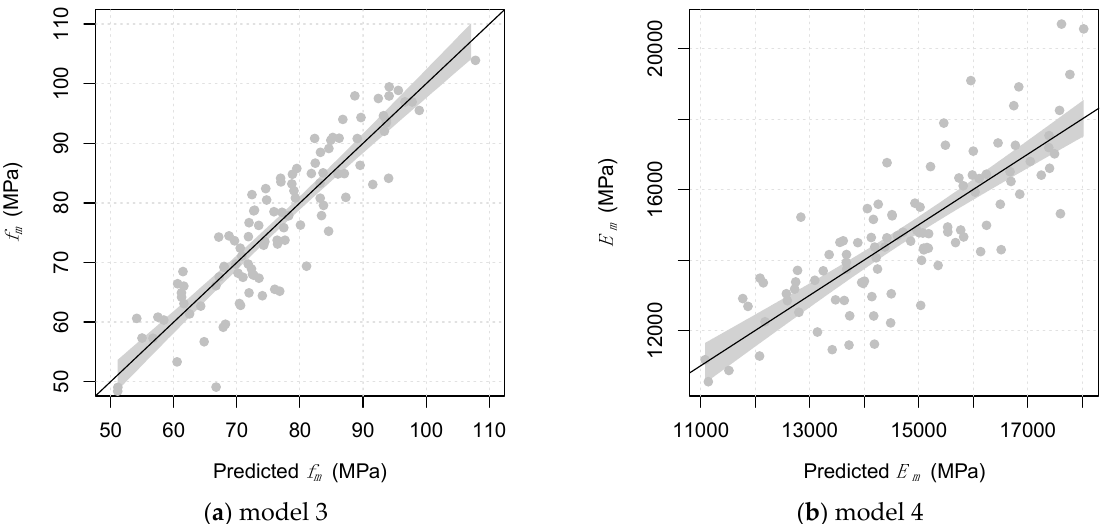
Figure 1. Observed vs. predicted values: ( a ) model three of Table 5 as the best model for the prediction of bending strength ( f m ); ( b ) model four of Table 5 as the best model for the prediction of static modulus of elasticity ( E m ). The grey shaded area represents the 95% confidence interval.